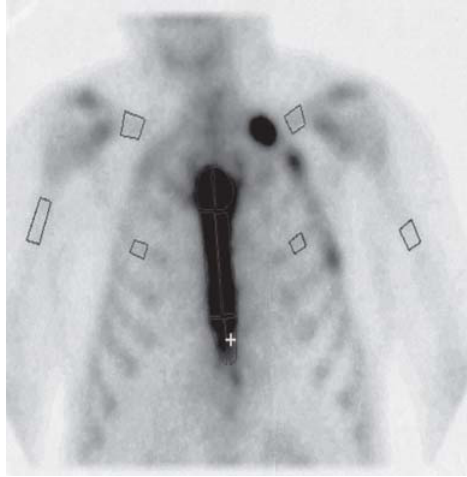
Fig. 2 - Imagem cintilográfica com delimitação das regiões de interesse (ROI), salientando-se a imagem da clavícula esquerda como ponto de